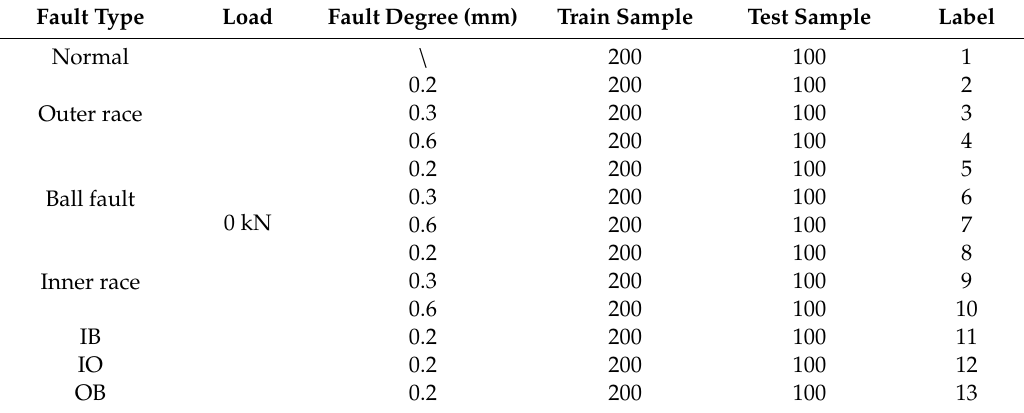
Table 3. Description of compound faults for dataset1. IB: inner-race fault and ball faults exist at the same time on the test bearing; IO: inner-race fault and outer-race fault exist at the same time; OB: outer-race fault and ball fault exist at the same time.